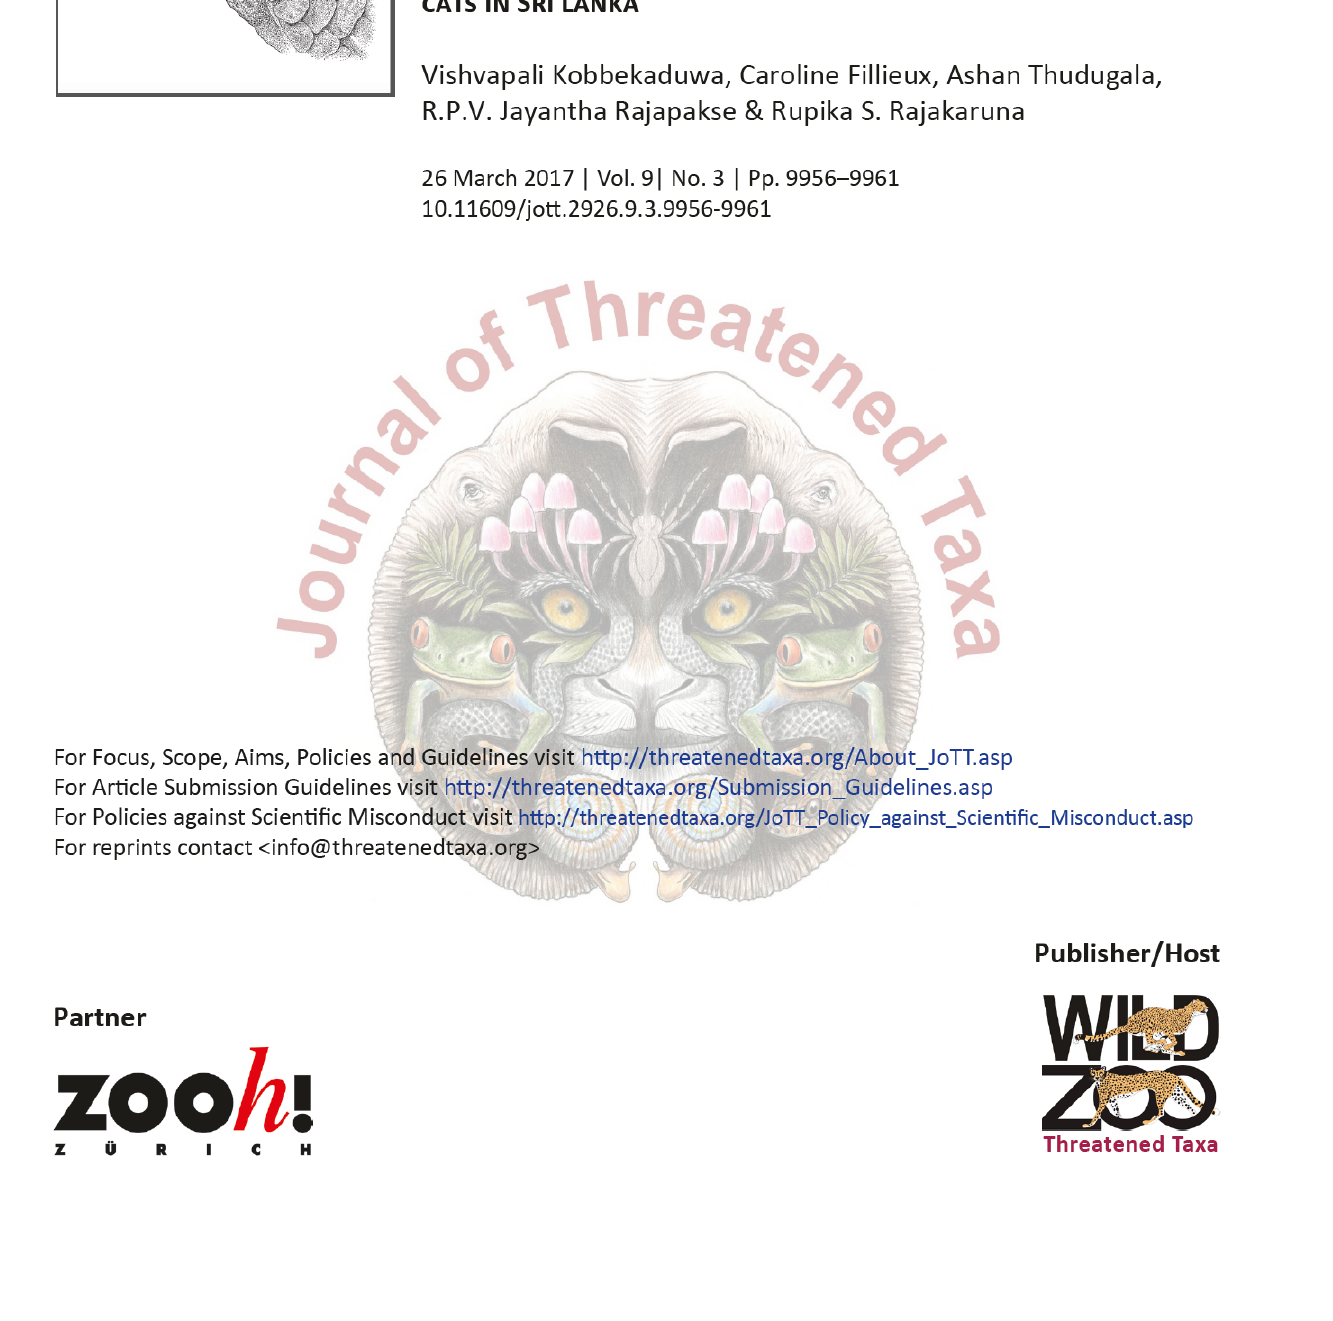
Ffirstt record off ttapeworm Monfiezfia (Cesttoda: Anoplocephalfidae) finffecttfions fin Leopards: